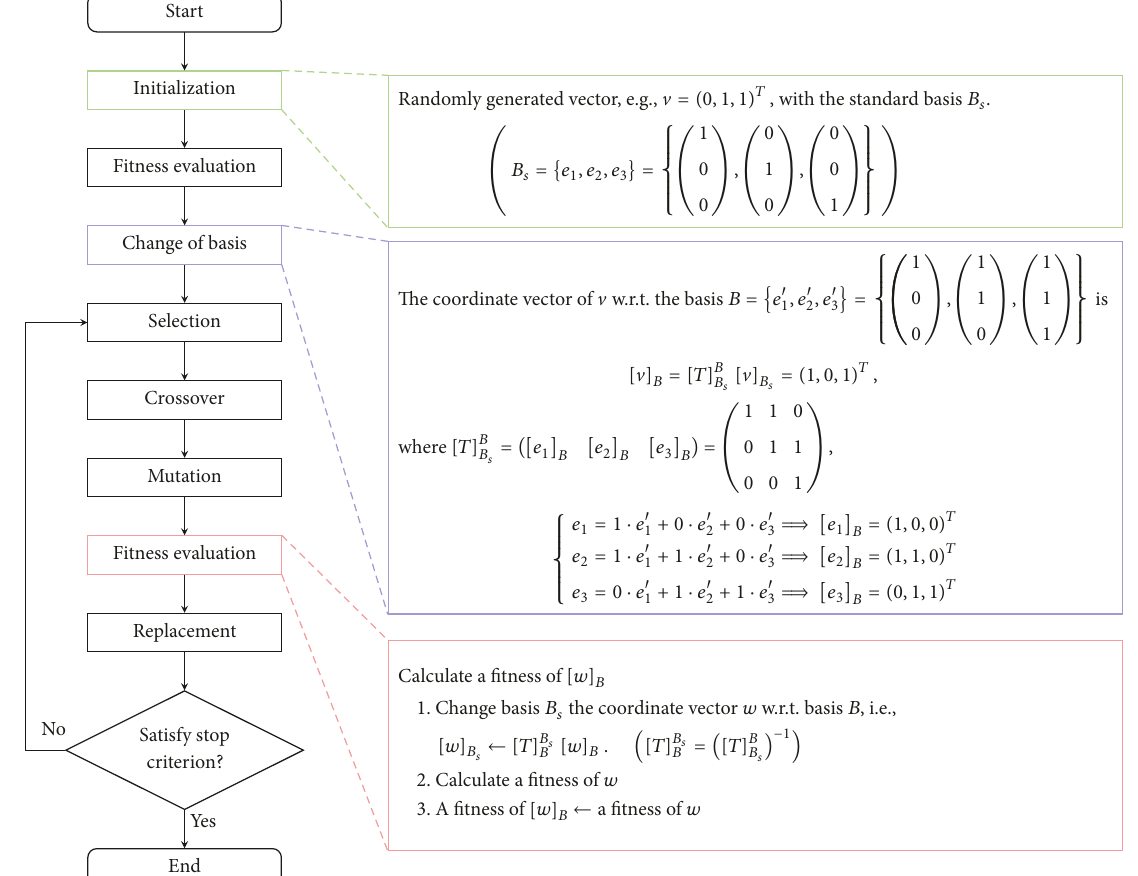
Figure 2: Flowchart of a GA with a change of